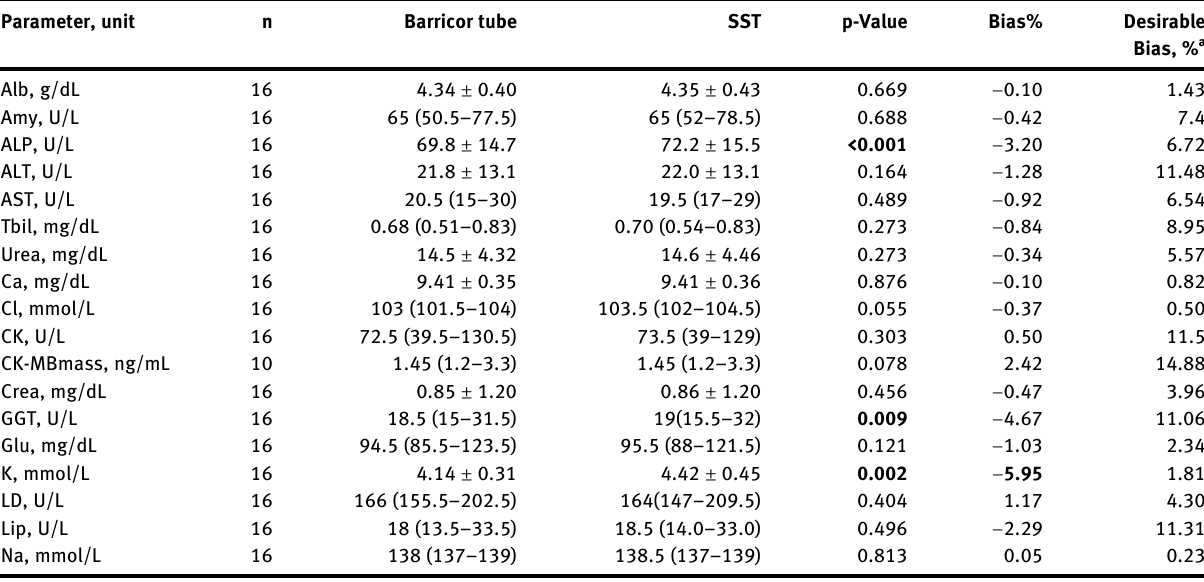
Table  : Descriptive statistics and comparison results for Barricor tube and SST in outpatient oncology patients. Parameter, unit n Barricor tube SST